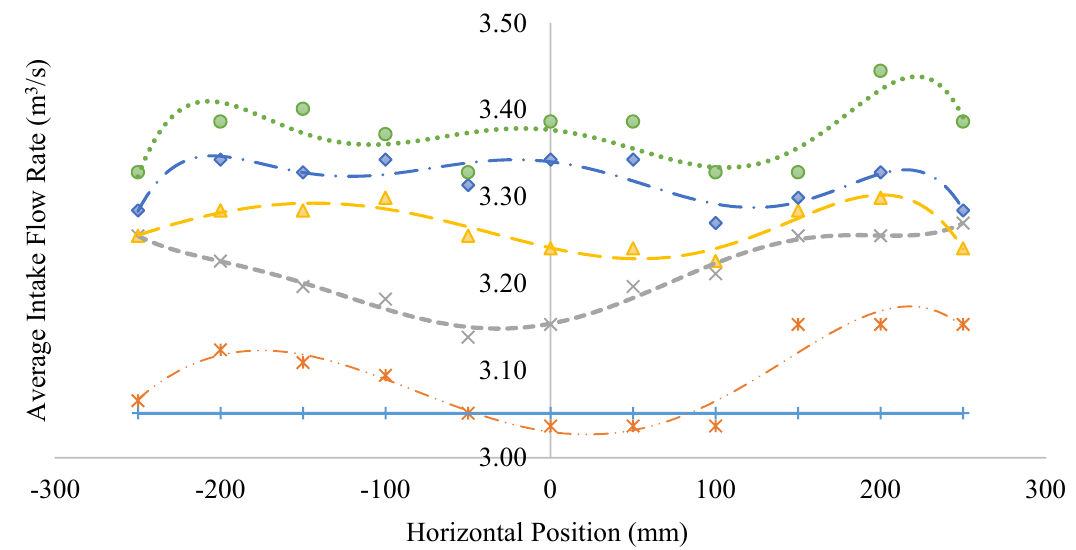
Figure 13. Average flow rate of the cooling tower model with various configurations.